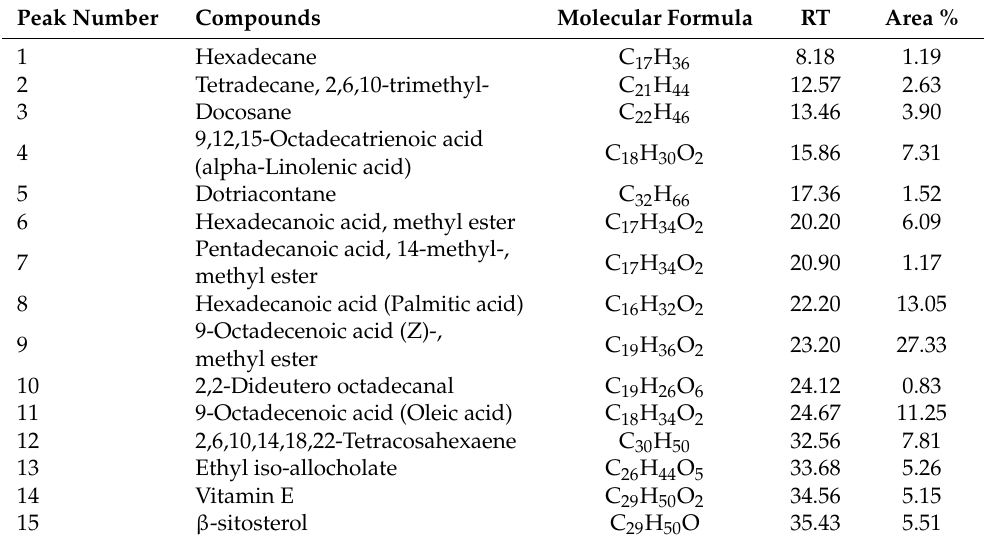
Table 1. Fatty acids and fatty acid methyl esters molecular formula, RT, and area (%) in olive oil. Peak Number